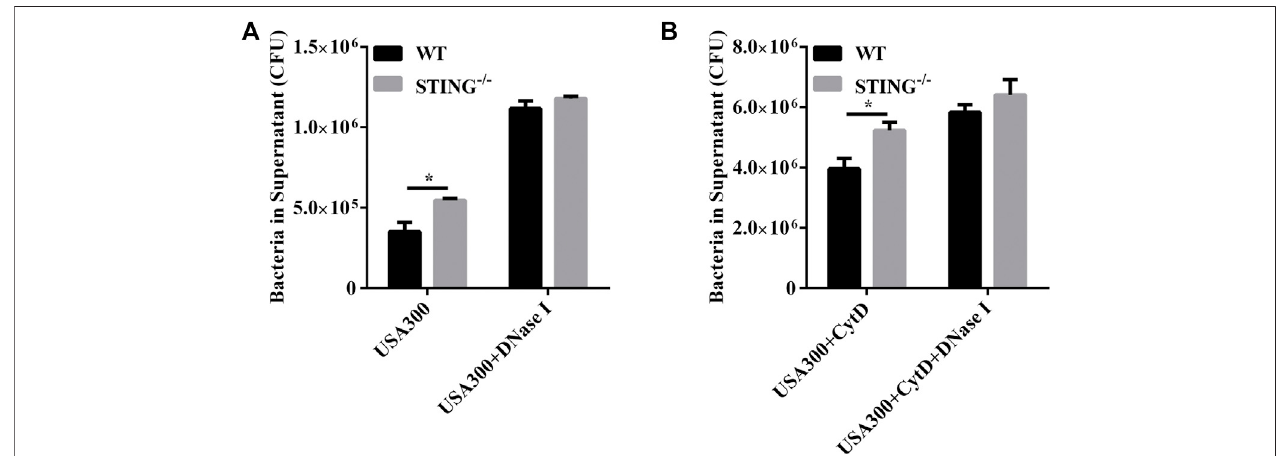
FIGURE5| STINGpromotesET-mediatedextracellularbacterialkillingby S.aureus infection. (A,B) WTandSTING -/- BMDMswerepretreatedwithDNaseI(100U/ mL) or CytD (10 μ M) for 20 min before infection with S. aureus (MOI: 20) for 3 h. The supernatants were collected and diluted, and the number of extracellular bacteria was determined. Data are shown as the mean ± SEM. Data were pooled from 3 independent experiments. Signi fi cance calculated using two-way ANOVA with Bonferroni ’ s multiple comparison test, * p < 0.05.